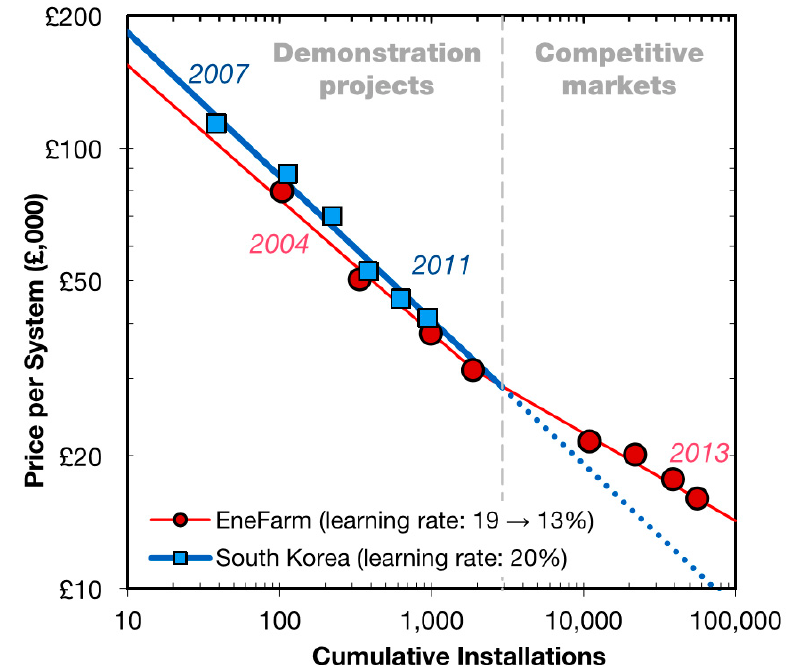
Figure 7. PEMFCs system cost for domestic purposes [132].